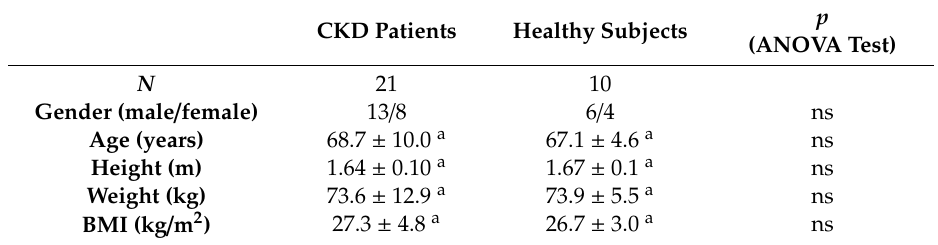
Table 1. Epidemiological findings of study population and evaluation of the homogeneity of the study groups.